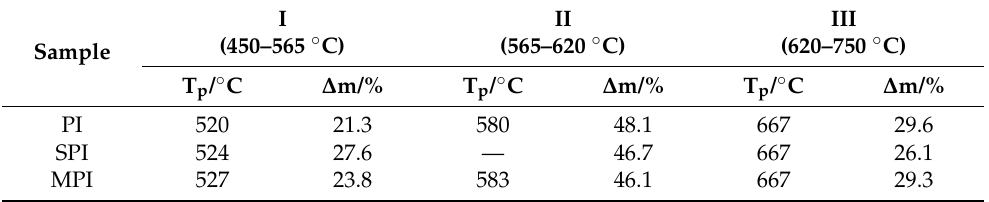
Table 2. Mass loss and peak temperature of the three substances at different stages.